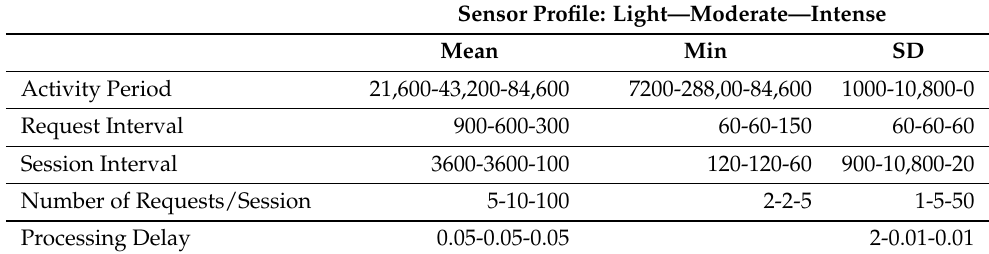
Table 5. Values used in the simulation for all three traffic types.